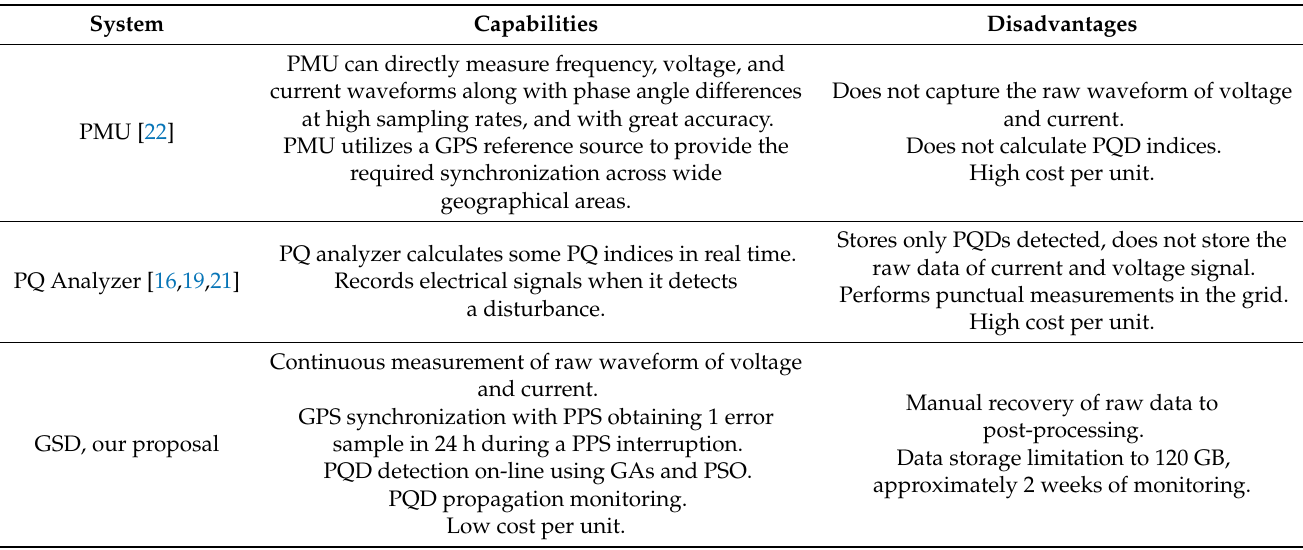
Table 2. Performance comparison of the devices used in different